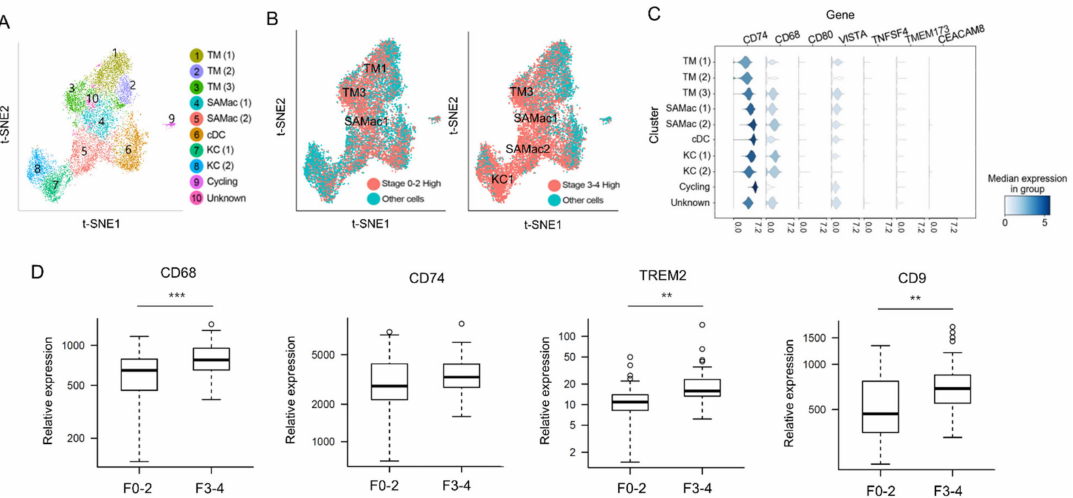
Figure 3. Combined analysis of scRNA-seq with DSP. ( A ) Reconstituted t-SNE graph for intrahepatic MPs using GEO datasets (GSE136103). ( B ) Marking differentially expressed proteins between early- stage fibrosis and advanced-stage fibrosis from DSP data to reconstituted t-SNE graph. Left panel is the graph that marked proteins highly expressed in F0–2, and right panel is the graph that marked proteins highly expressed in F3–4. ( C ) Scaled gene expression across every cluster of MPs. ( D ) Gene expression analysis with snap-frozen liver tissues using NanoString nCounter expression analysis. The expression levels of CD68, CD74, TREM2, and CD9 were compared between livers with early fibrosis and advanced fibrosis. Significance was indicated with ** p value < 0.01, *** p value <